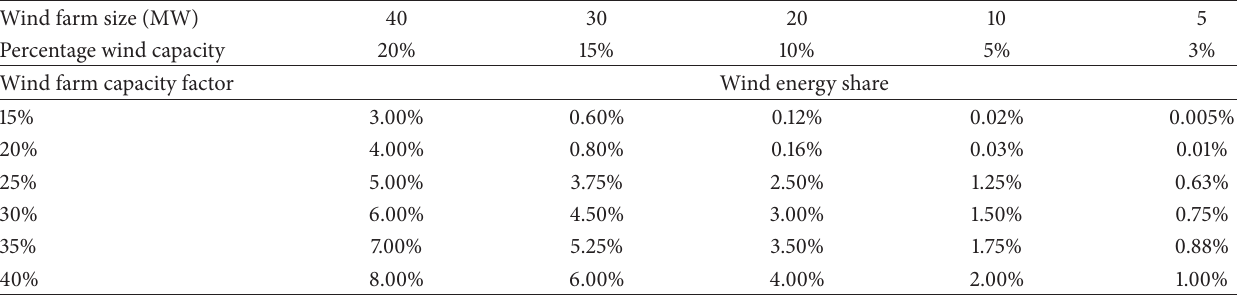
Table 5: Dimensioning the wind contribution to NGCC + wind combination.